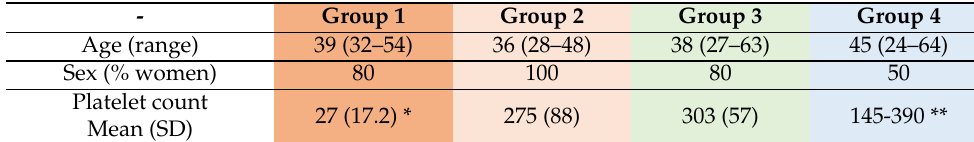
Table 1. Characteristics of the study participants.